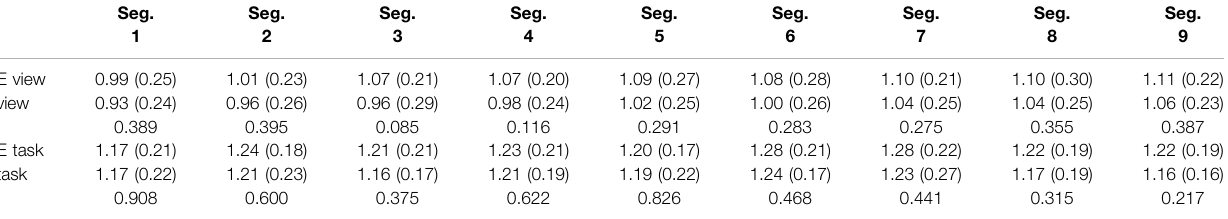
TABLE 3 | DFA α 1 comparison between Pure Regime and Mixed Regime participants in both viewing and task. All numbers except p -values are presented as mean (SD). Seg. 1